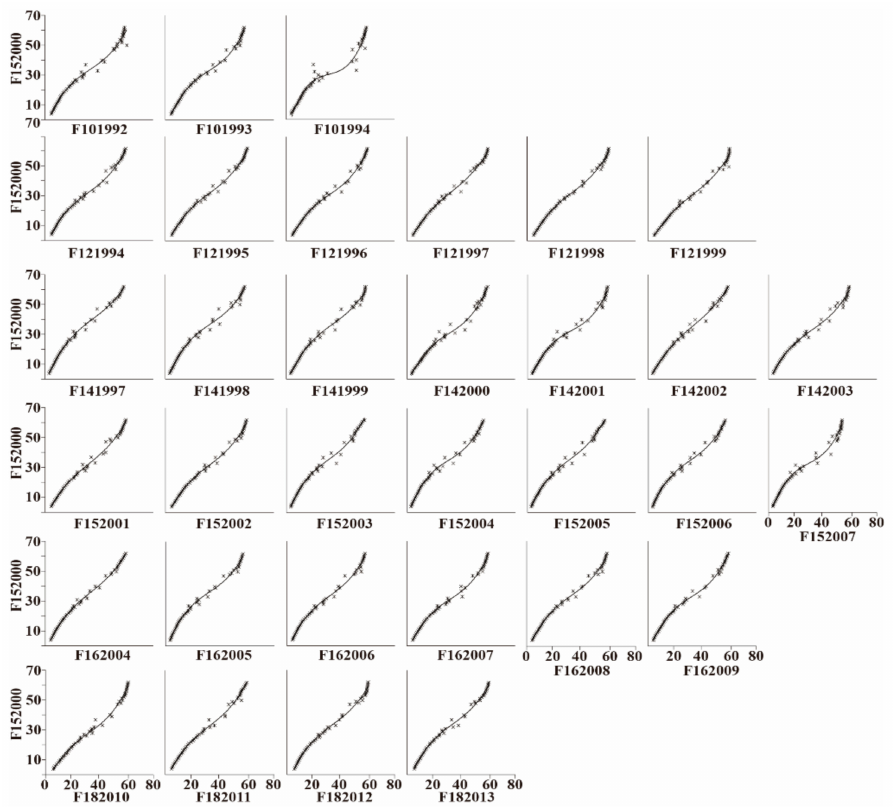
Figure 5. The image pair scatter plot and ridgeline from F101992 to